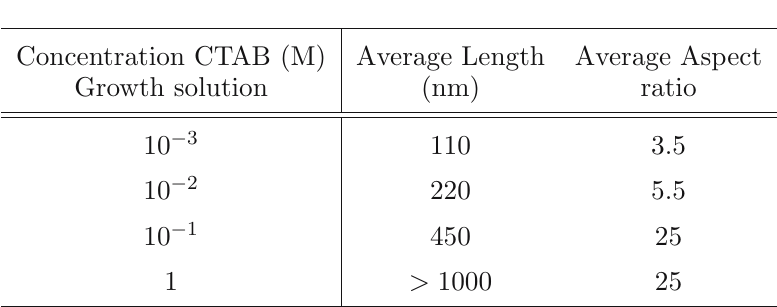
Table 1 Average lengths and aspect ratios for nanorods as measured by SEM, for different surfactant